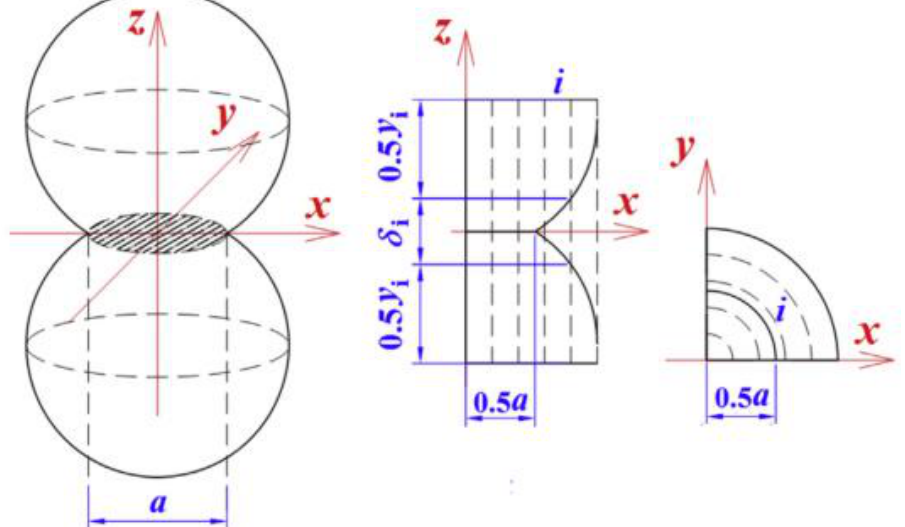
Figure 10. Gas-solid coupling thermal conductivity model established by Zhao et al. [25] ( a and i represent the contact area of the particles and the i th hollow cylinders in the cylindrical unit cell, respectively).